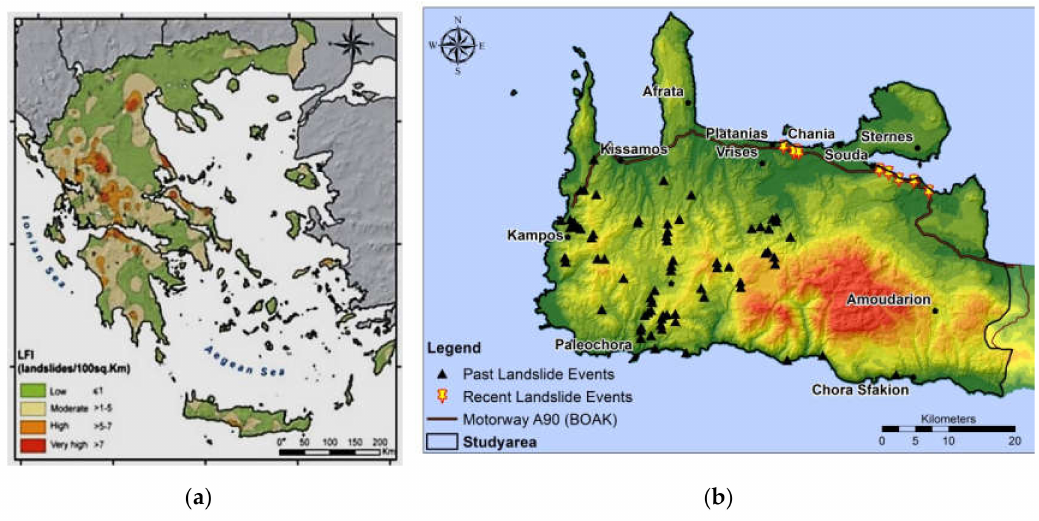
Figure 3. ( a ) The Landslide Frequency Index (LFI-landslides / 100 km 2 ) map of Greece [22], ( b ) The past and recent (2018–2019) landslide events in Chania prefecture